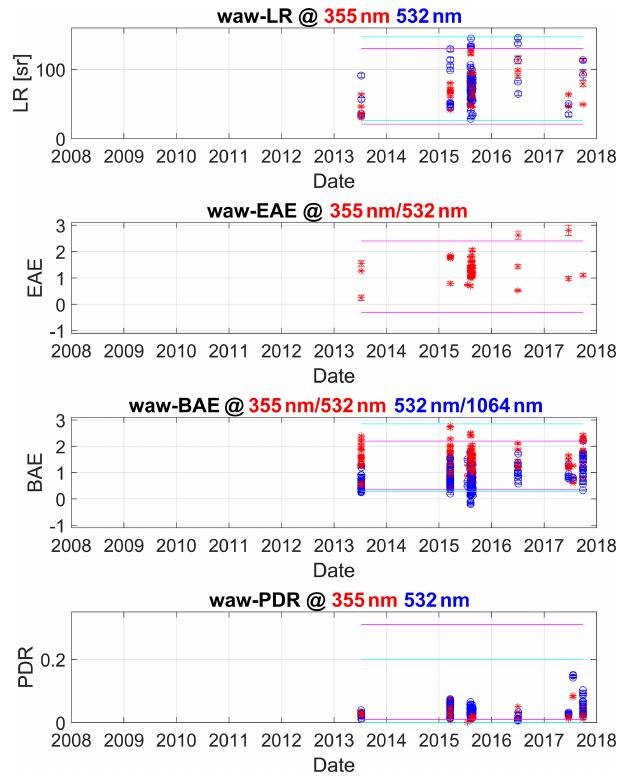
Figure 6. Intensive aerosol parameters derived in the layers. Exam- ple for Warsaw (“waw”) station. The lines represent the minimum and maximum values reported in the literature. Magenta lines rep- resent the extreme values for the intensive parameters shown in red, while the cyan lines represent the extreme values for the intensive parameters shown in blue. Layers have fire source